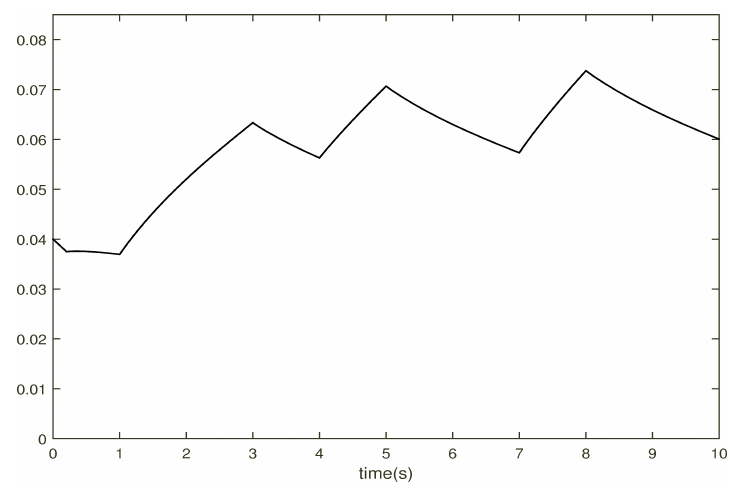
Fig. 6. The evolution of x T ( t ) ρ of system